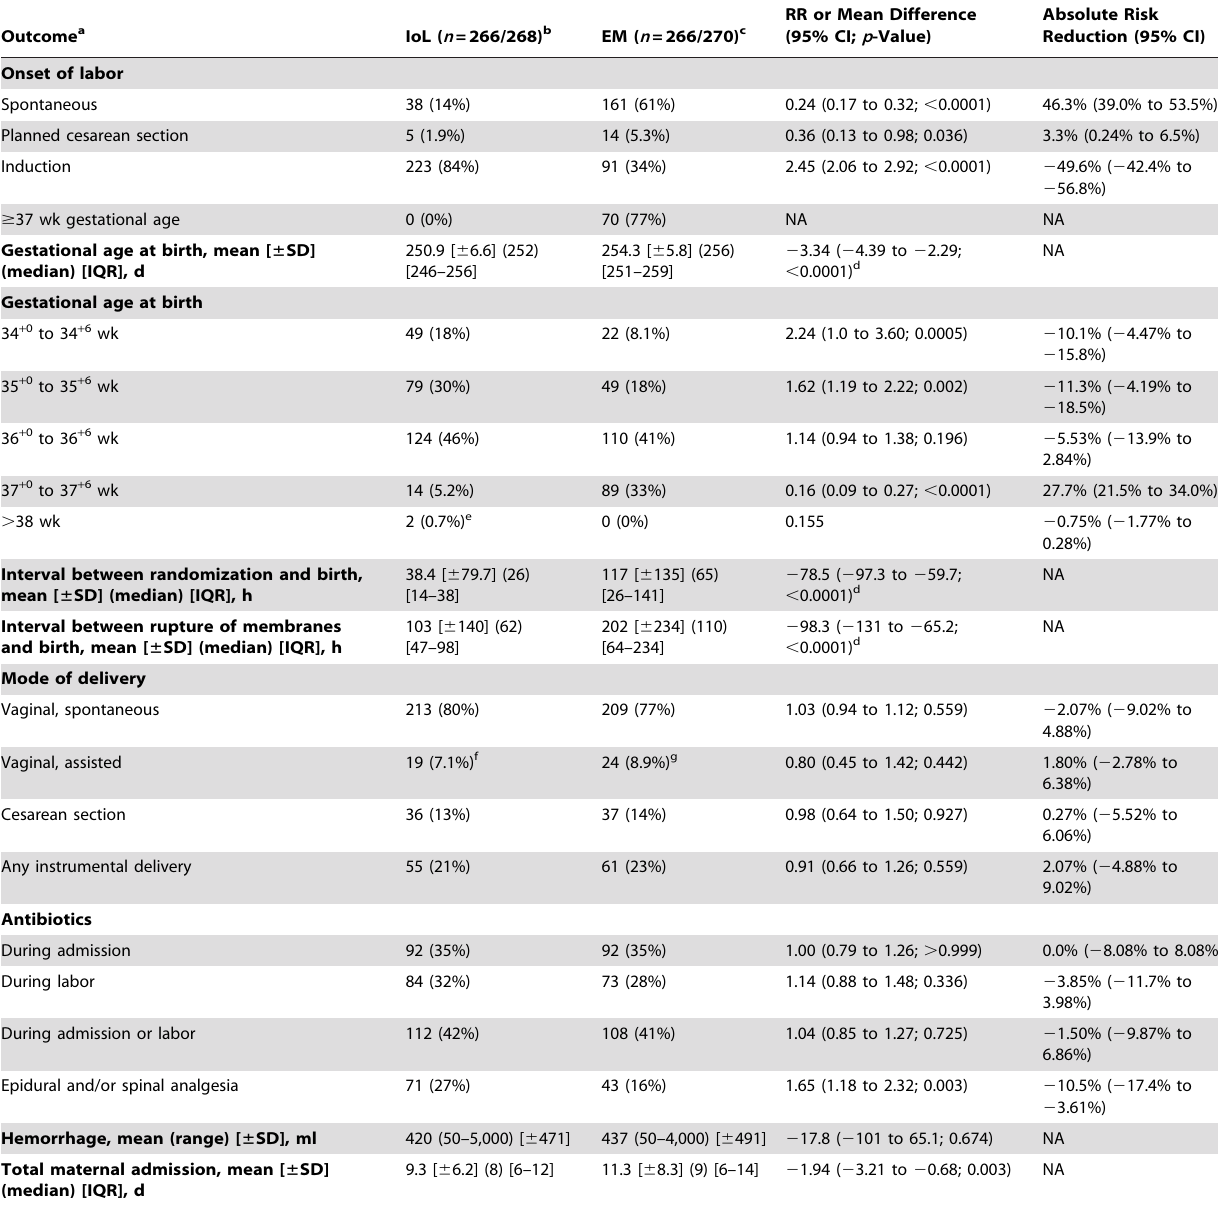
Outcome a IoL ( n =266/268)